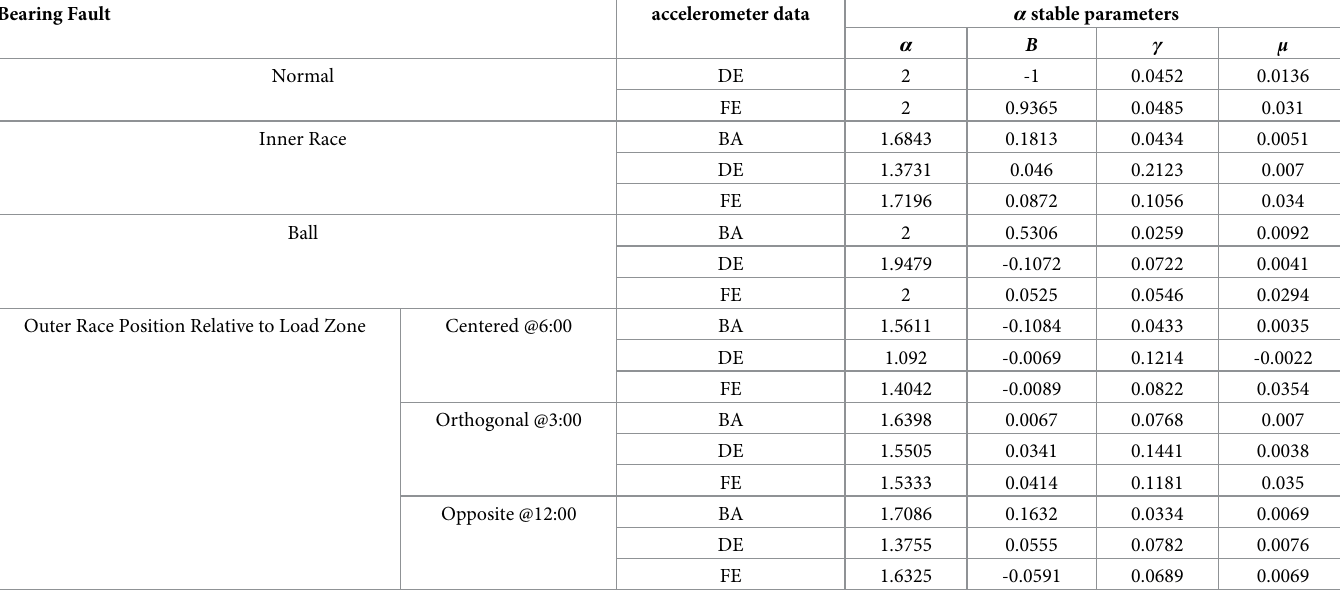
Table 1. α stable distribution parameter estimation of the normal and drive end bearing fault data. Bearing